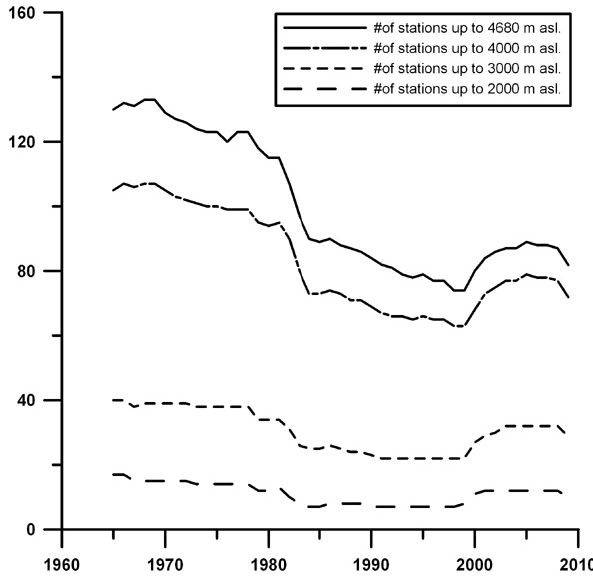
Figure 2. Frequency distribution per altitude class of climatologi- cal stations in the Cusco-Apurimac region that are accessible in the PACC data